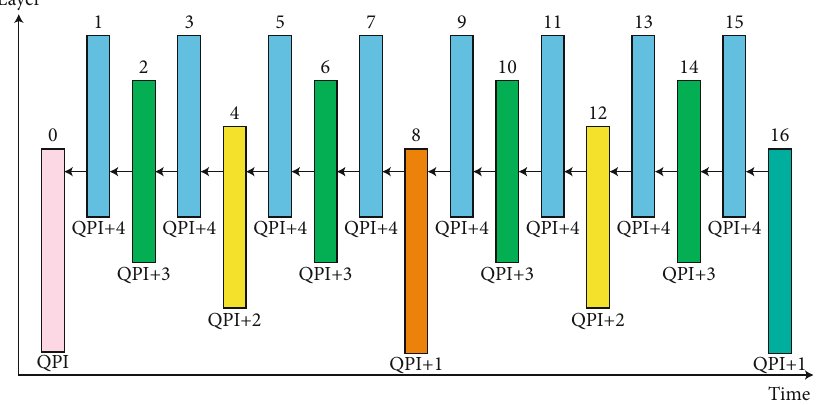
Figure 8: Low-Delay con fi guration.